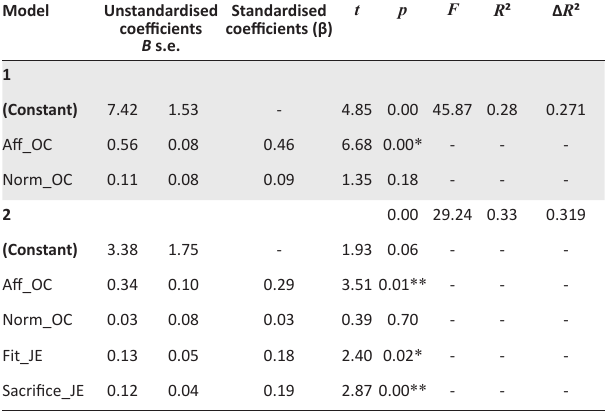
TABLE 3 : Multiple regression with turnover intention the dependent variable and affective commitment, normative commitment (organisational commitment) and organisational fit, organisational sacrifice (job embeddedness) the independent variables.